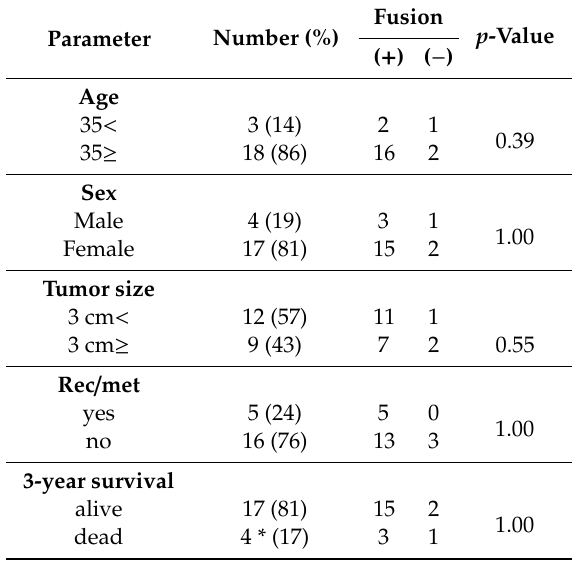
Table 1. Correlation of fusion status and clinicopathologic features of acinic cell carcinomas (AcCC).